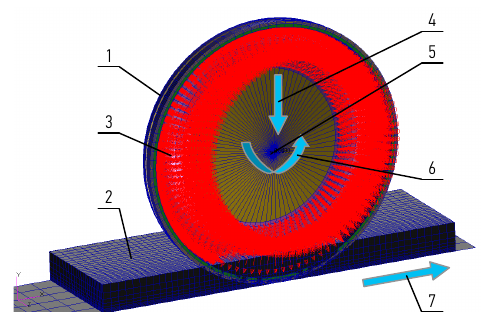
Fig. 4 . Simplified model of tire175/65/R14: 1 – protector; 2 – rubber; 3 – belt; 4 – shoulder; 5 – rim Table. Material properties of the tire components (Park et al.